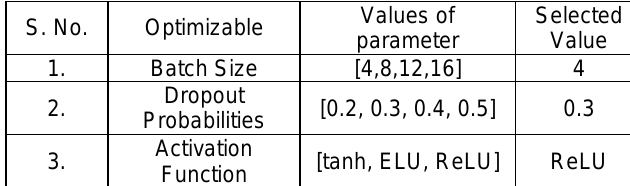
Table 1. Parameter optimization for RSISC-16